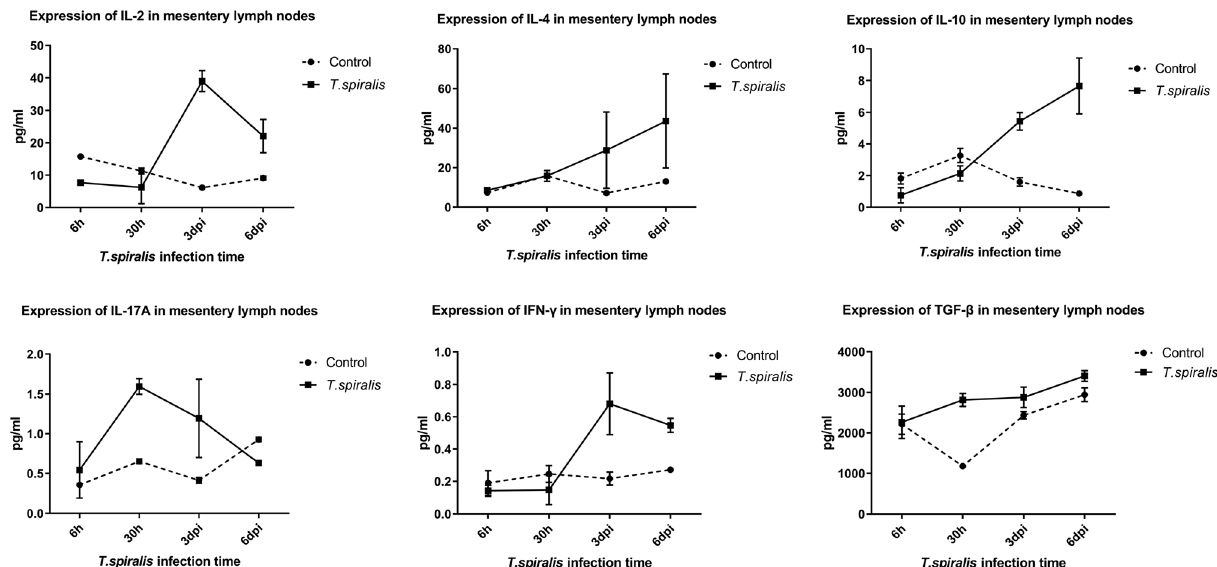
Figure 1. Cytokine expression levels of IL-2, IL-4, IL-10, IL-17A, IFN- c , and TGF- b in the mesentery lymph nodes in mice infected with 250 muscle larvae of Trichinella